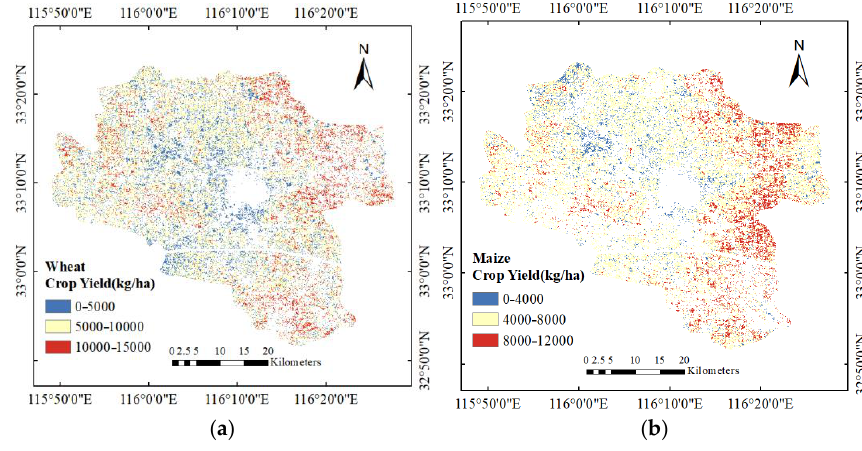
Figure 10. Crop yield. ( a ) Winter wheat; ( b ) Summer maize.